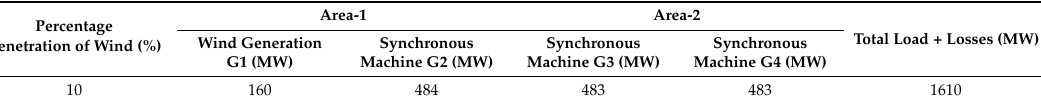
Table 1. Load flow data.